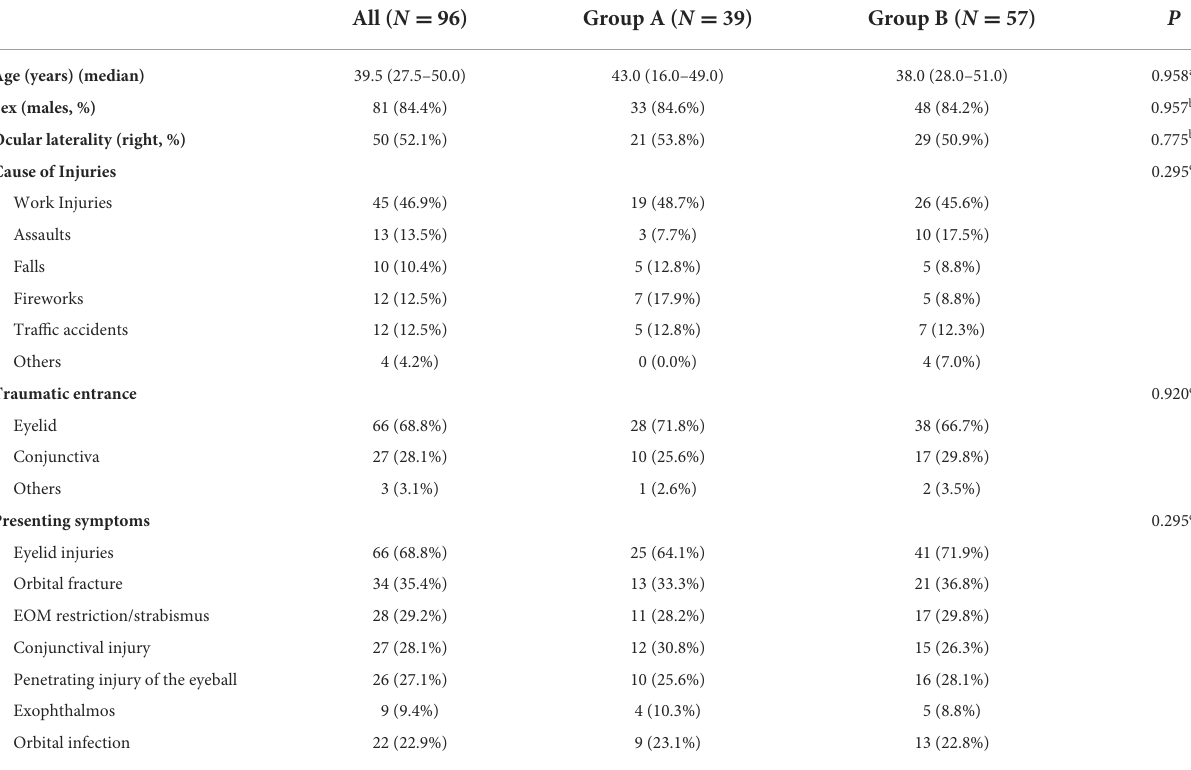
TABLE 1 Clinical characteristics of the 96 patients with intraorbital foreign